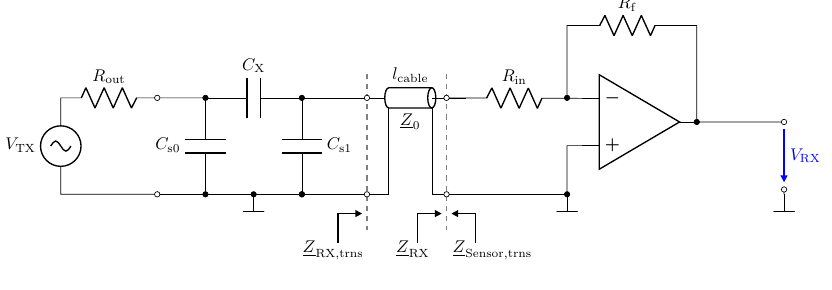
Figure 17. Matched receiver circuit connected to a capacitive Π -network by means of a transmission line with length l cable and impedance Z 0 = 50 Ω . R in = R out = 50 Ω , R f = 500 Ω , C X = 1pF, C s0 = C s1 =